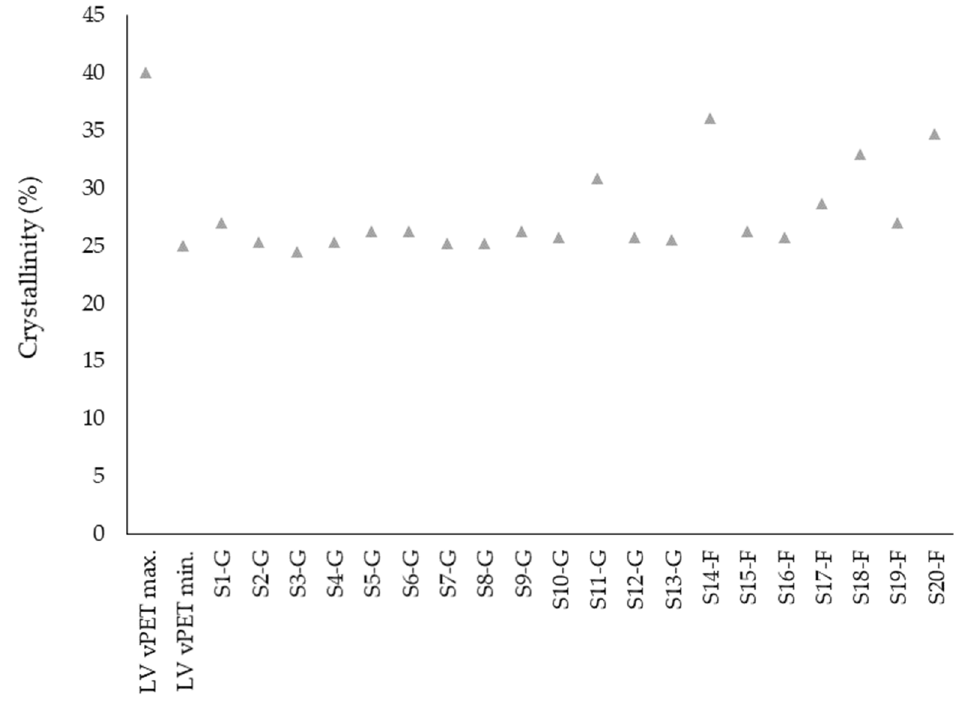
Figure 6. Crystallinity of rPET samples in comparison with literature values for vPET.